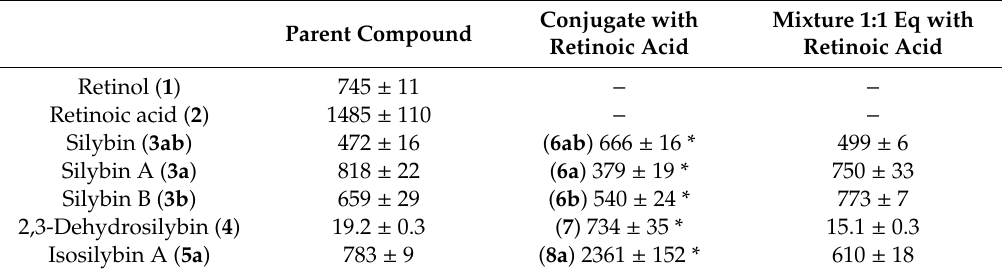
Table 1. 1,1-Diphenyl-2-picrylhydrazyl (DPPH) radical scavenging activities (IC 50 [ µ M]) of retinoic conjugates in comparison with their parent compounds and their equimolar mixtures. Parent